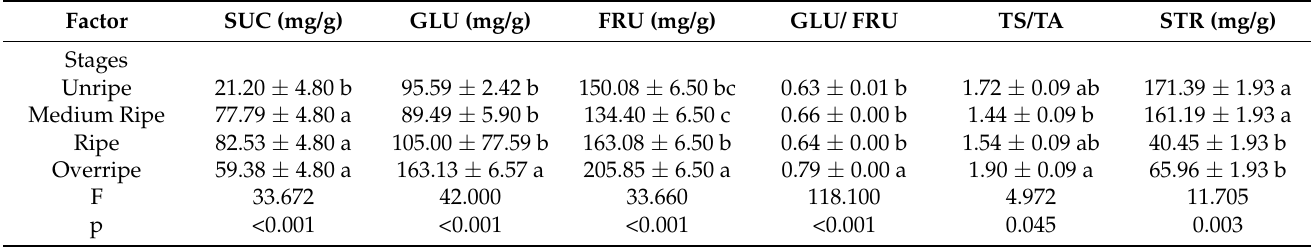
Table 2. ANOVA for sucrose (SUC), glucose (GLU), fructose (FRU), glucose/fructose ratio (GLU/FRU), total sugars/total organic acids (TS/TA), and starch (STR) expressed in dry weight and considering the four development stages of H. edulis “ubajay” harvested in Moreno (Buenos Aires). Values represent means ± standard